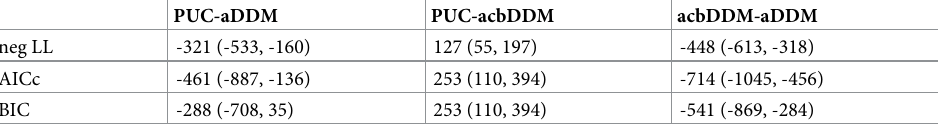
Table 1. Comparing the main PUC model to alternative models according to negative log likelihood (not corrected for the number of free parameters), AICc, and BIC. Lower values are better for the first-mentioned model. All values are summed across subjects; bootstrapped 95% confidence intervals are given in